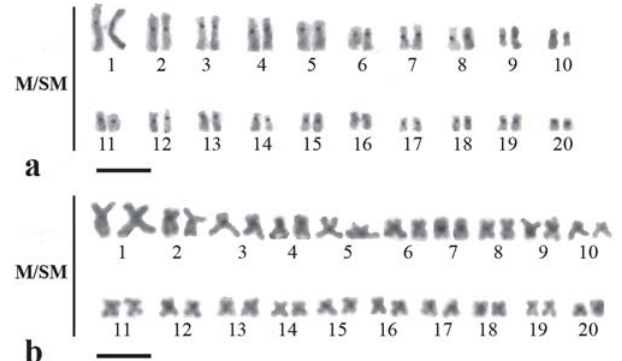
Fig. 3. C-banded karyotypes of Hoplias malabaricus from Contas River basin (a) and Itapicuru River basin (b). Bar = 10µ.